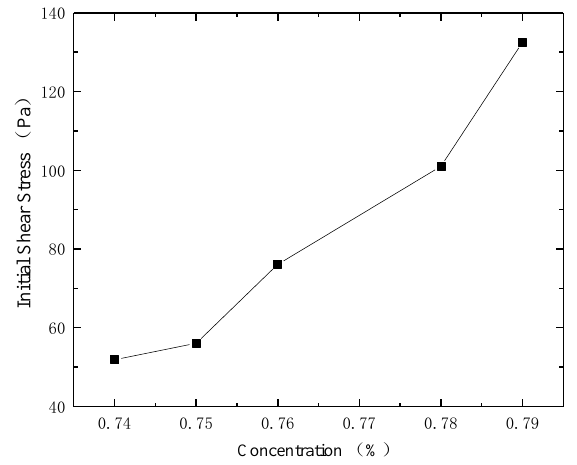
Figure 9. Relation between initial shear stress and slurry mass concentrations.